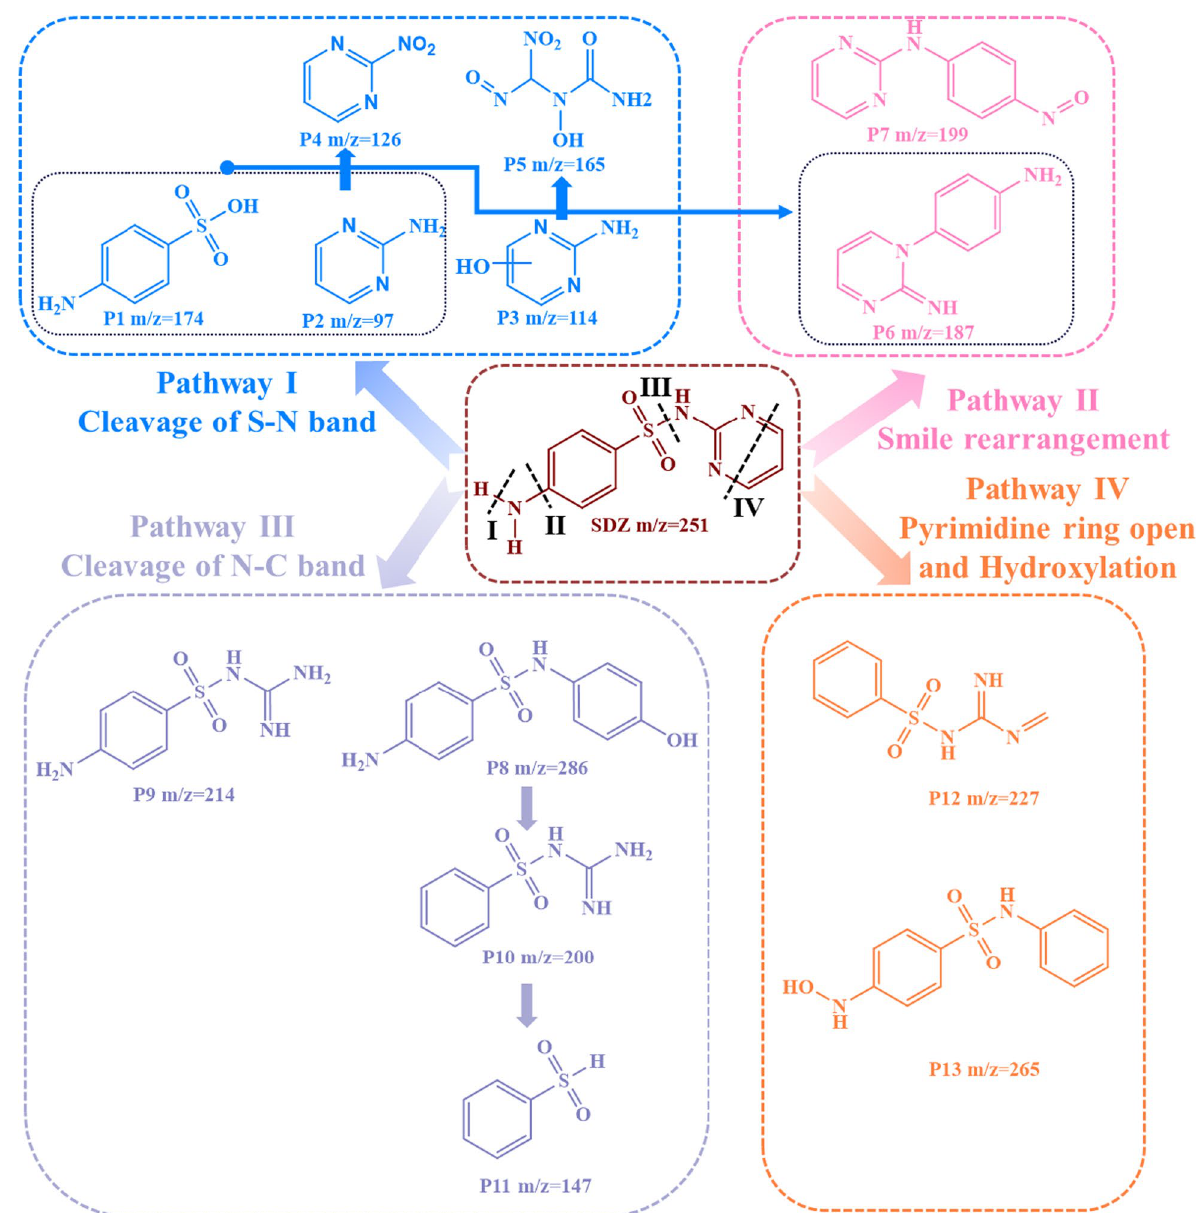
Fig. 6 Possible degradation pathways of SDZ in the SK-C/PDS